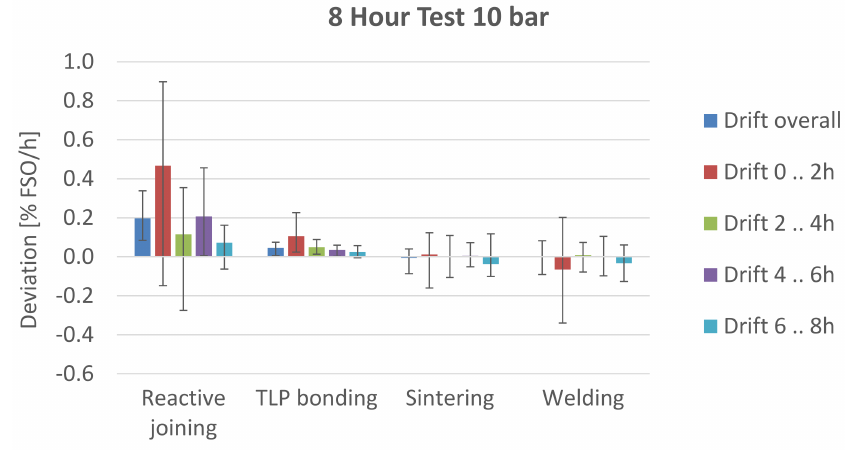
Figure 14. Results of drift test.